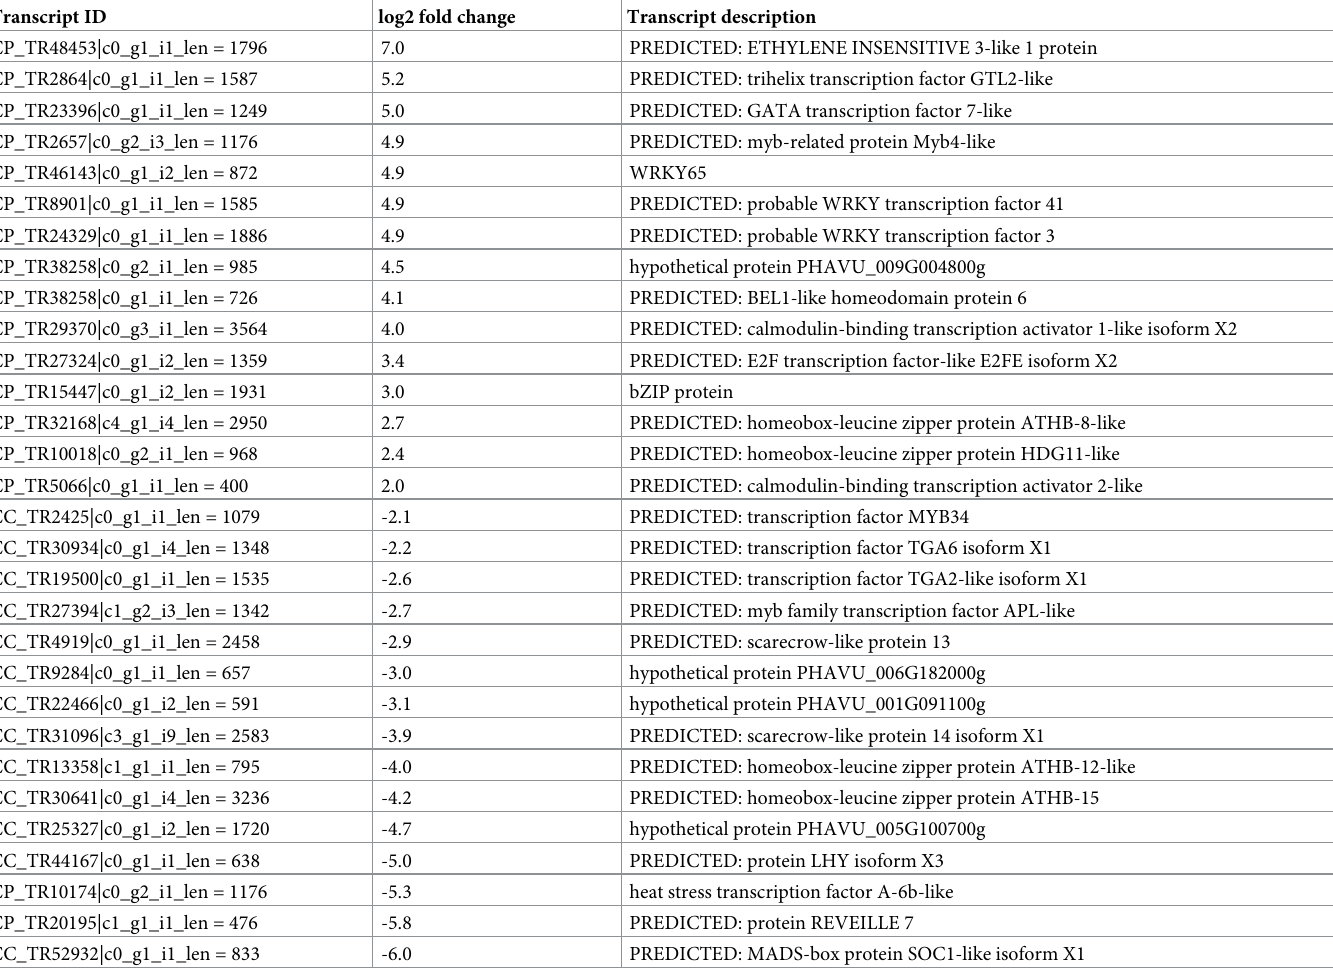
Table 1. Representative transcripts of transcription factors differentially expressed in C . platycarpus compared to C . cajan